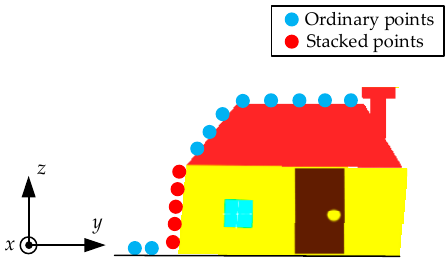
Figure 5. Schematic geometry of the data stack on the building facade.